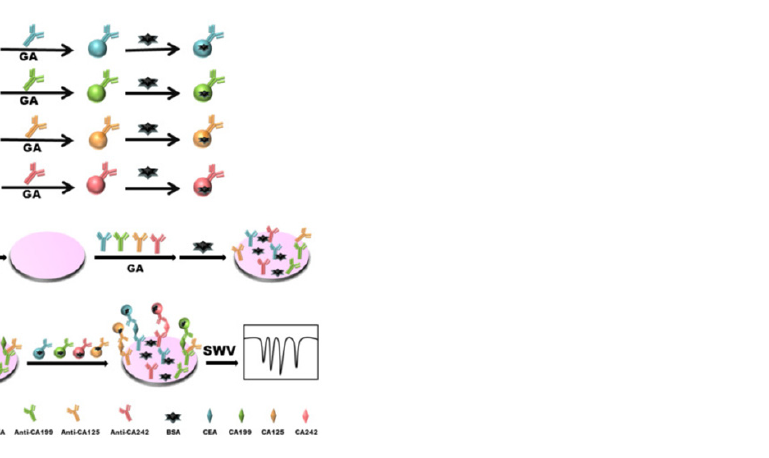
Figure 3. Preparation of various immunoprobes based on metal ions doped chitosan-poly(acrylic acid) nanospheres ( A ). Schematic representation for the electrochemical multiplexed immunosensor of CEA, CA 19-9, CA 12-5, and CA 24-2 ( B ) (reprinted with permission from Ref. [62], Copyright 2016, Elsevier).